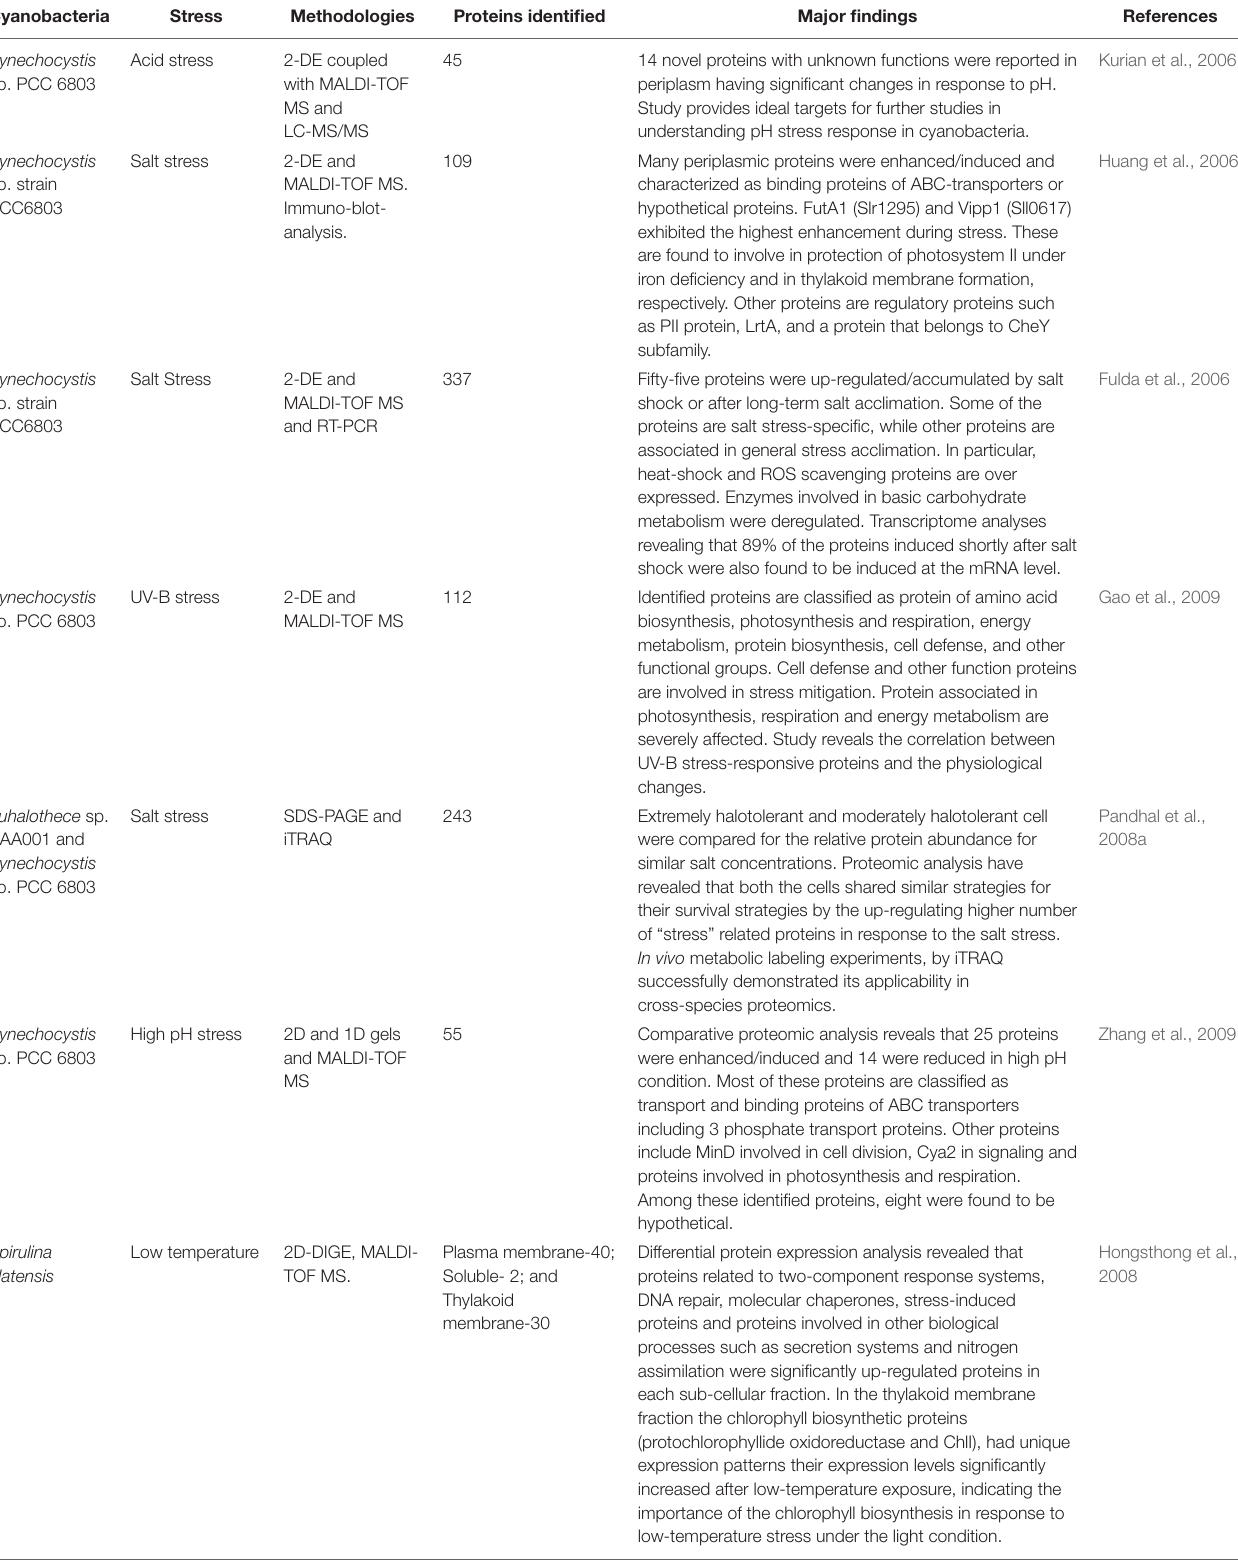
TABLE 1 | A summary of articles published dealing with cyanobacterial proteome analyses in response to various abiotic stresses.